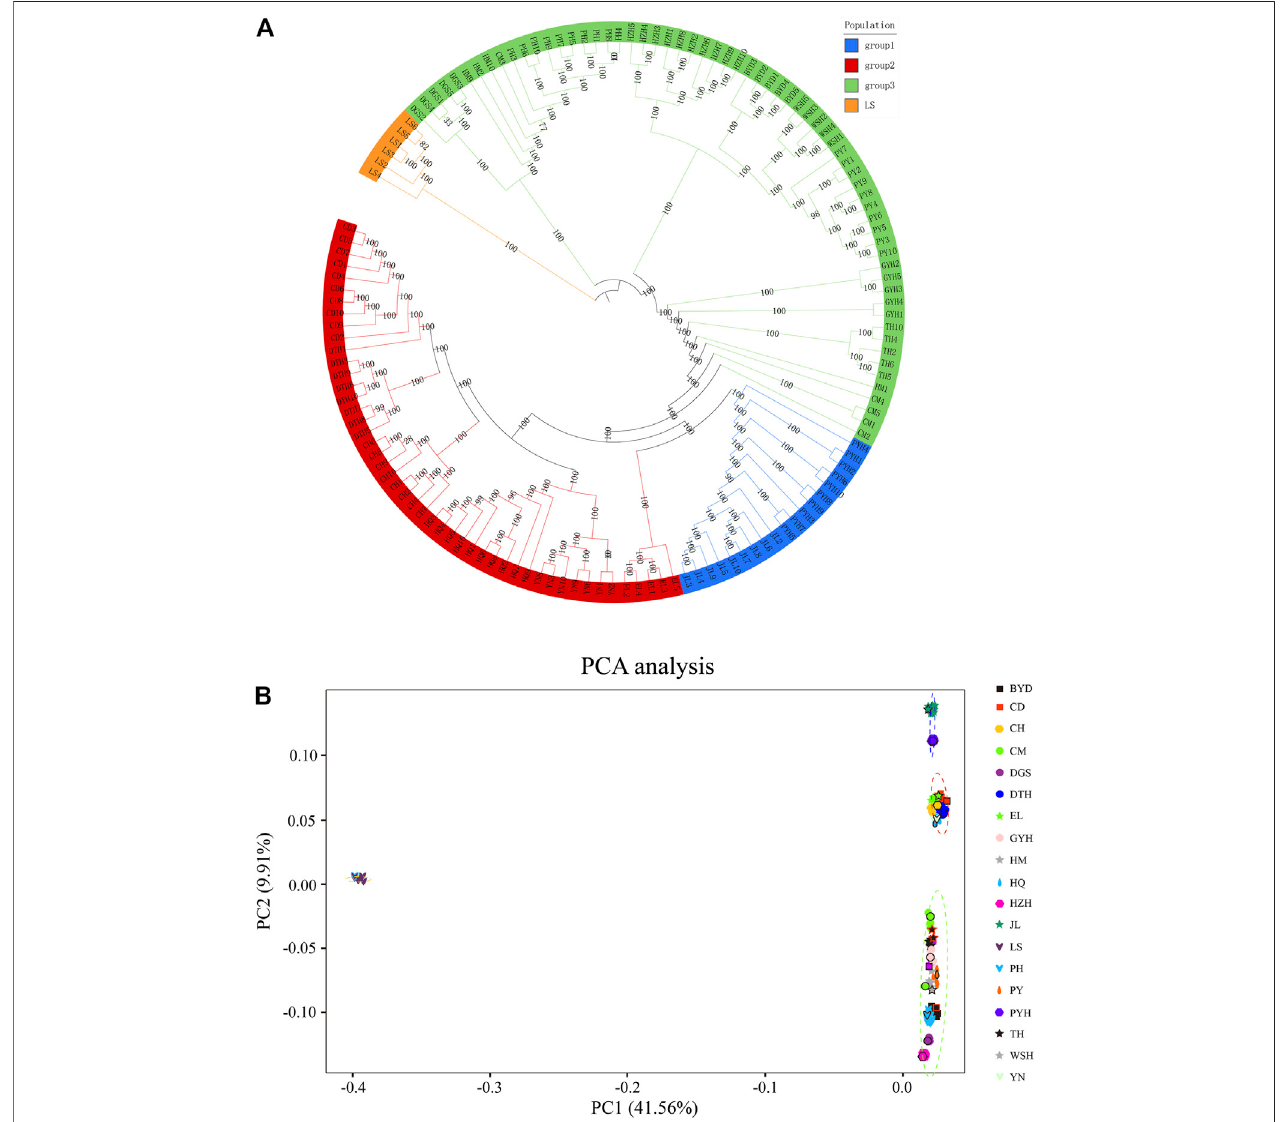
FIGURE 2 | Phylogenetic tree (A) and principal component analysis (PCA) (B) based on single nucleotide polymorphisms (SNPs). The abbreviations represent sampling sites: BYD, Baiyangdian Lake; CD, Chengdu City; CH, Chaohu Lake; CM, Chongming Island; DGS, Dagushan; DTH, Dongting Lake; EL, Eli village; GYH, Gaoyou Lake; HM, Haimen City; HQ, Huoqiu County; HZH, Hongze Lake; JL, Jiaoling County; LS, Lingshui County; PH, Pinghu City; PY, Puyang City; PYH, Poyang Lake; TH, Tai Lake; WSH, Weishan Lake; YN,